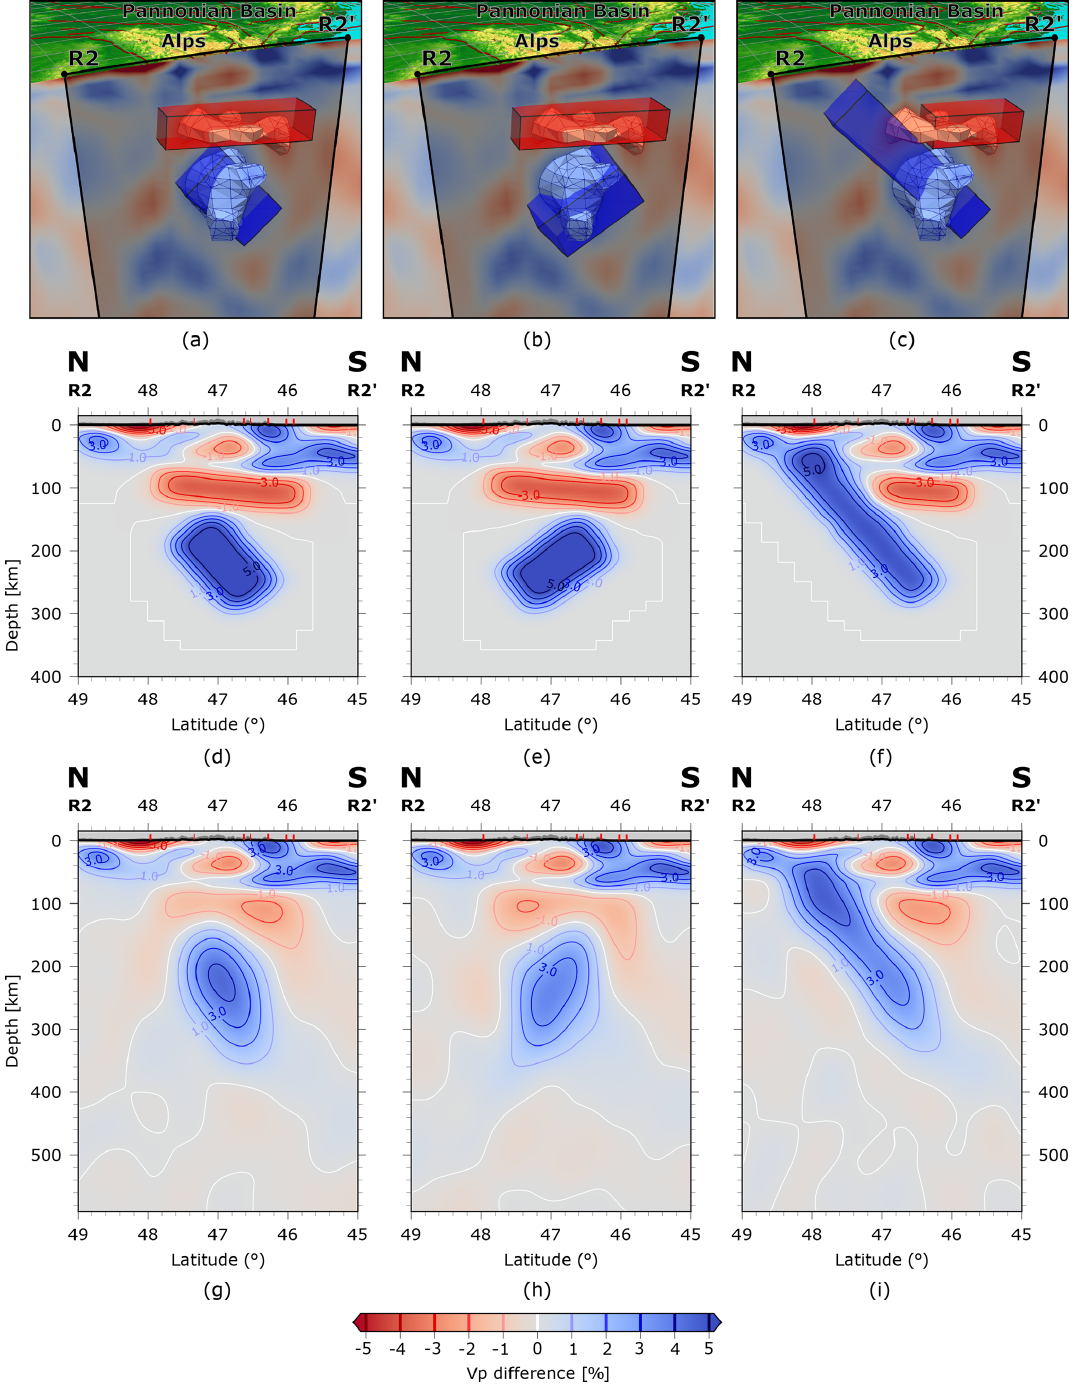
Figure 15. Resolution analysis for profile E at longitude 13 . 3 ◦ E. (a, b, c) 3D models of the three different test cases for (a) a delaminated slab dipping to the south, overlain by a low-velocity zone; (b) an identical case but with a northward-dipping slab; and (c) a slab connected to the European lithosphere with a low-velocity zone representing upwelling mantle. Meshed volumes show velocity perturbation iso-surfaces of P-wave velocity increase of 2% of the actual model results. Semi-transparent rectangular boxes show positions of the modelled anomalies for the resolution test. (d, e, f) Vertical profile through the resulting spatially smoothed synthetic slabs, after importing them into the velocity grid. (g, h, i) Recovered structures after 12 inversion